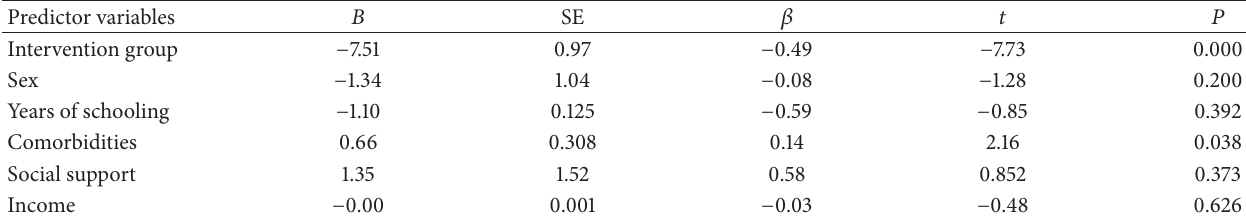
Table 3: Predictors of self-care at the end of six months in the model with six variables ( 𝑛 = 188 ). Predictor variables 𝐵 SE 𝛽 𝑡 𝑃 Intervention group − 7.51 0.97 Sex − 1.34 Years of schooling − 1.10 0.125 Comorbidities Social support